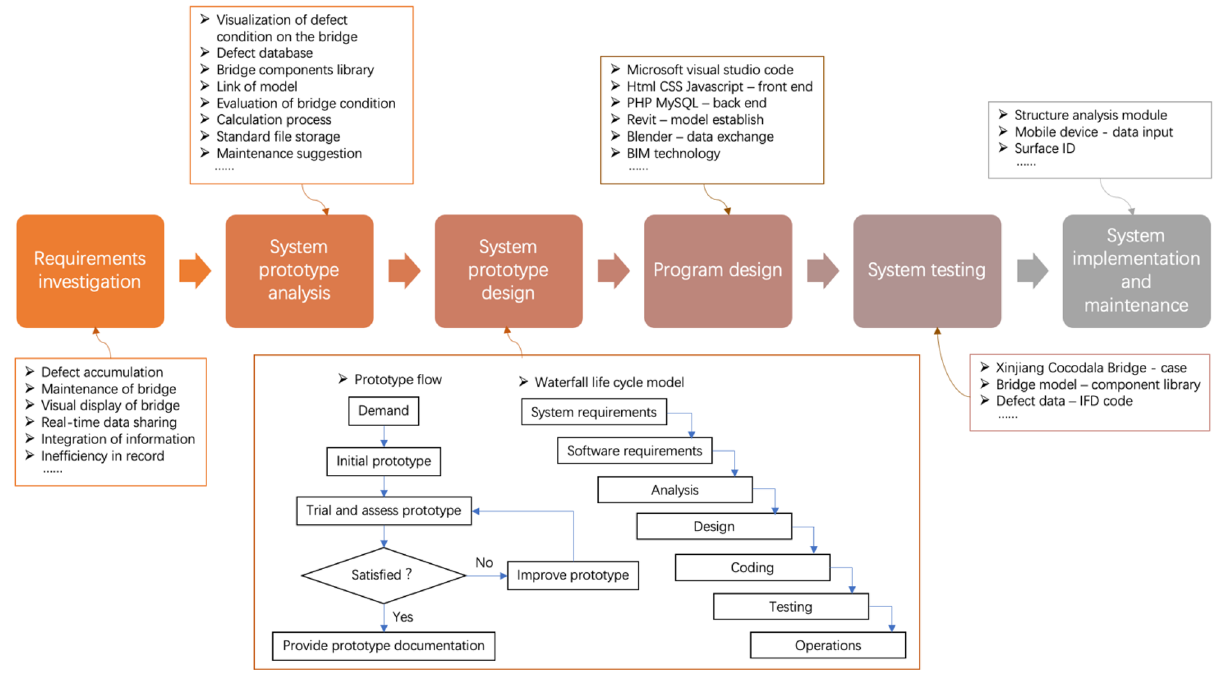
Figure 1. Development flow of the BIM-based bridge maintenance system.